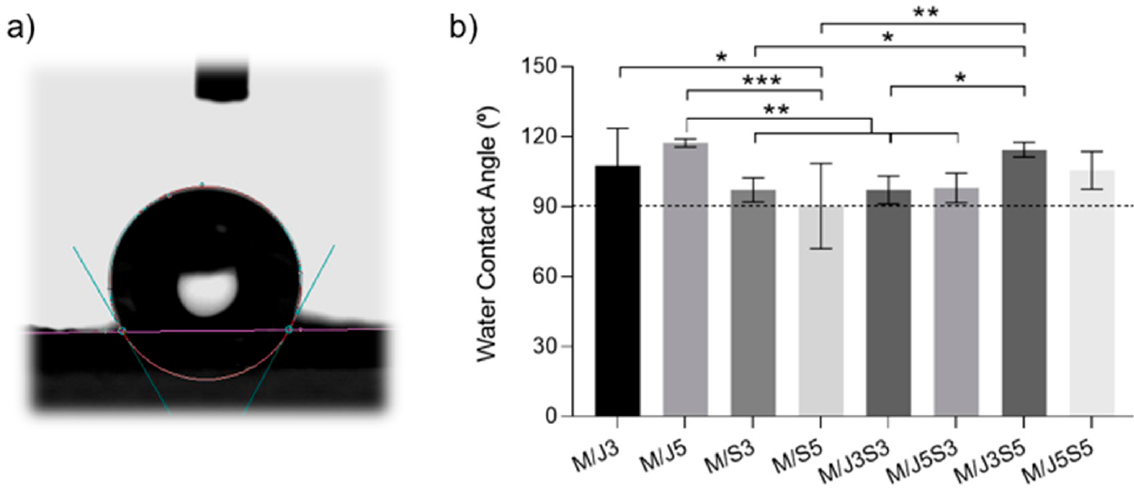
Figure 6. Water contact angle (WCA) measurements for the study of surface hydrophilicity on the polymeric membranes: ( a ) representative image of a water droplet deposited on the membrane surface, and ( b ) statistical analysis of the mean water contact angle obtained for the different membranes. Results are exhibited as mean ± standard error of three independent experiments. Statistical analysis of multiple comparison test ( p < 0.05) was performed, showing a significance of * ( p < 0.05), ** ( p < 0.01), and *** ( p < 0.001).